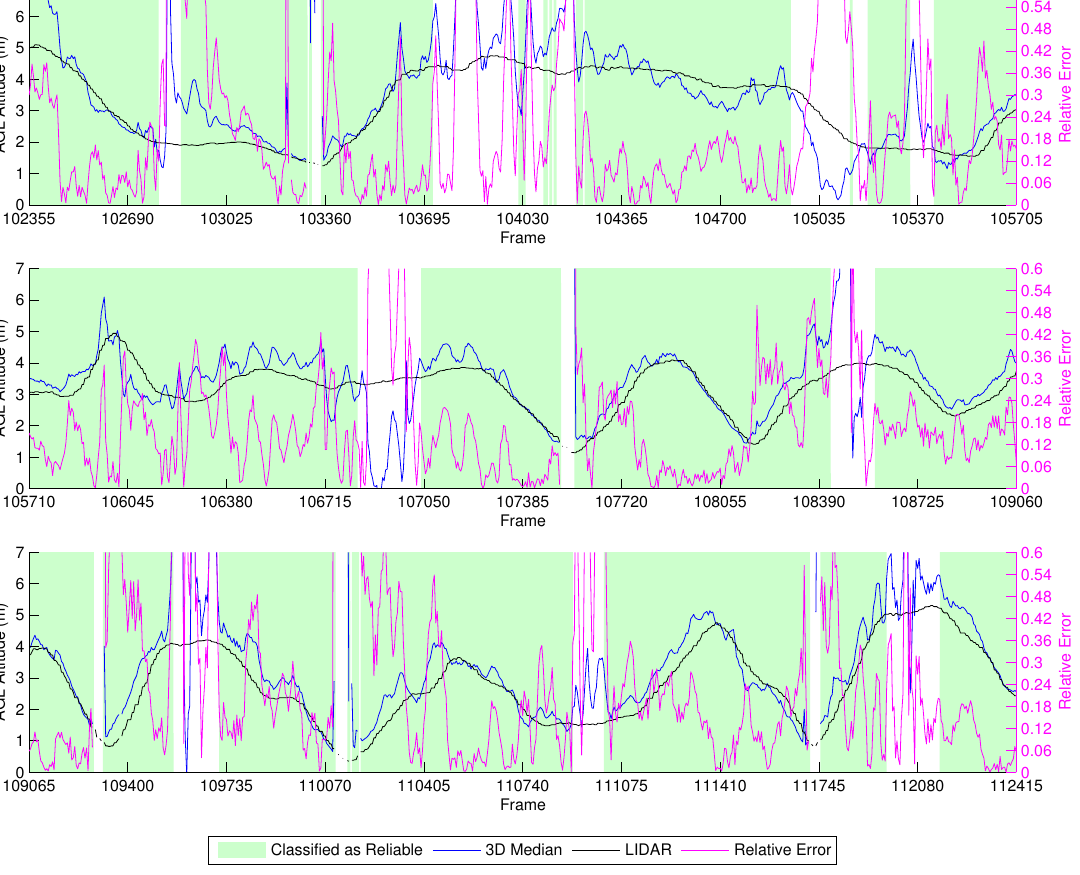
Figure 17. Height estimation results for the manual vertical zig-zag